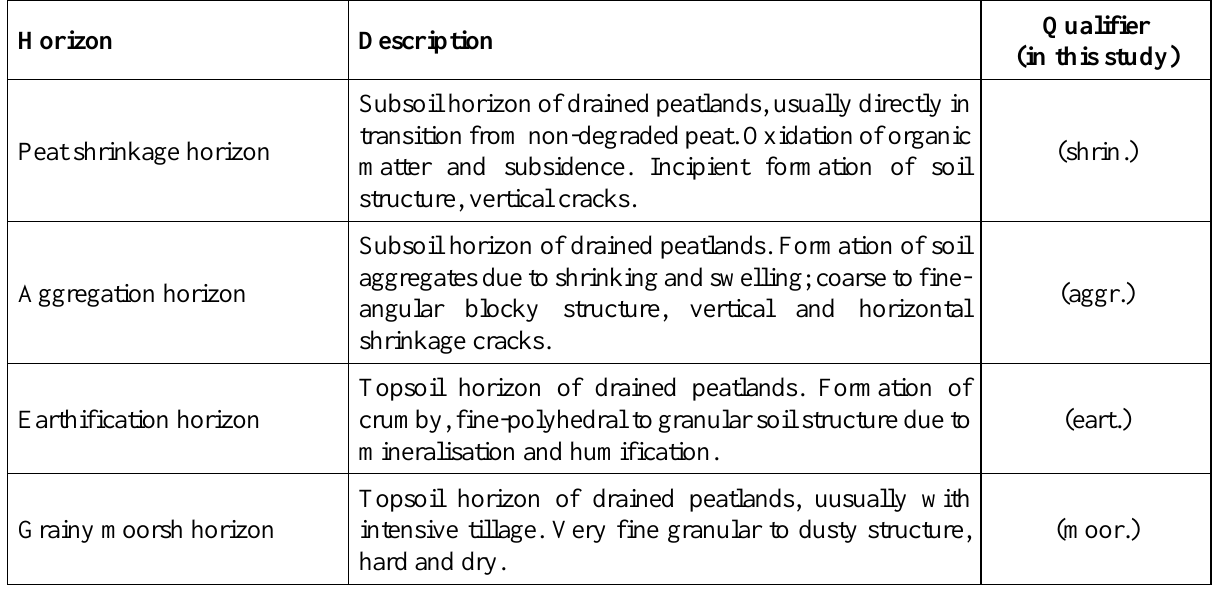
Table 2. Horizons of the moorsh formation process, adapted from Ilnicki & Zeitz (2003) and Ad-hoc-AG Boden (2005).